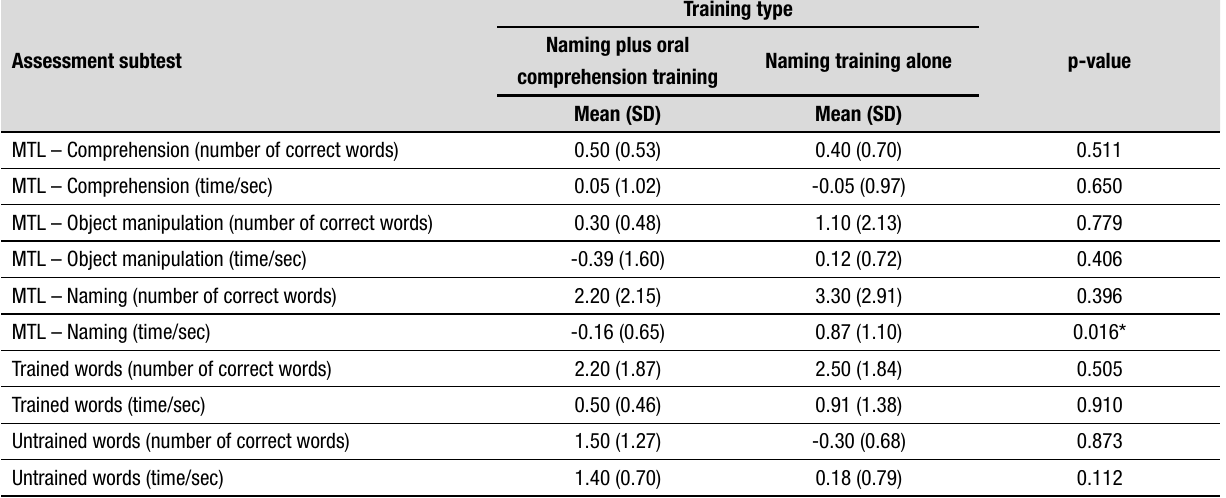
Table 4. Comparison of language performance for training interventions.